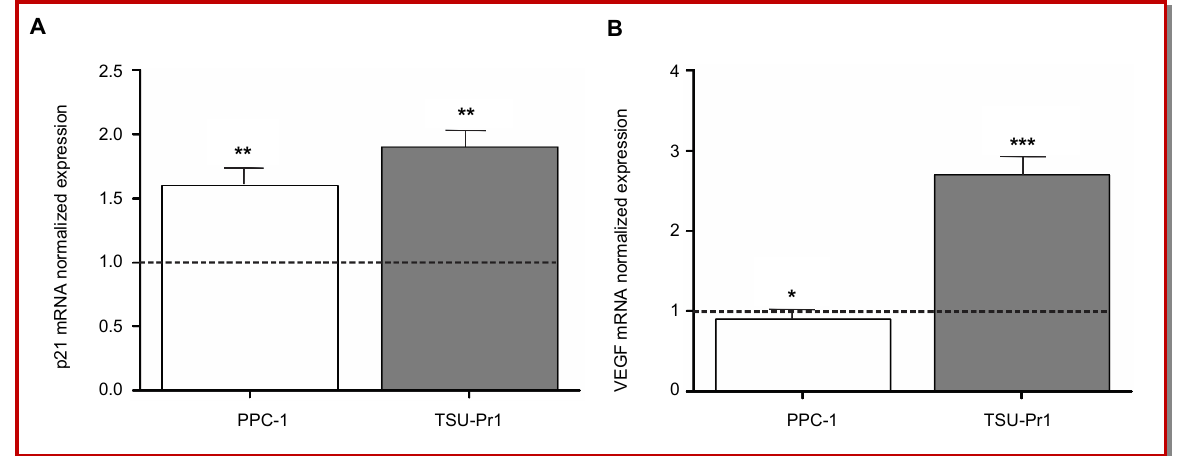
Figure 5: Effect of axitinib and dasatinib on mRNA levels of p21 (A) and VEGF (B) in PPC-1 and TSU-Pr1 cells determined by real- time PCR. Results are expressed as fold-variation relatively to control (dashed line) after normalization with b-2-microglobulin, GAPDH and/or 18S housekeeping